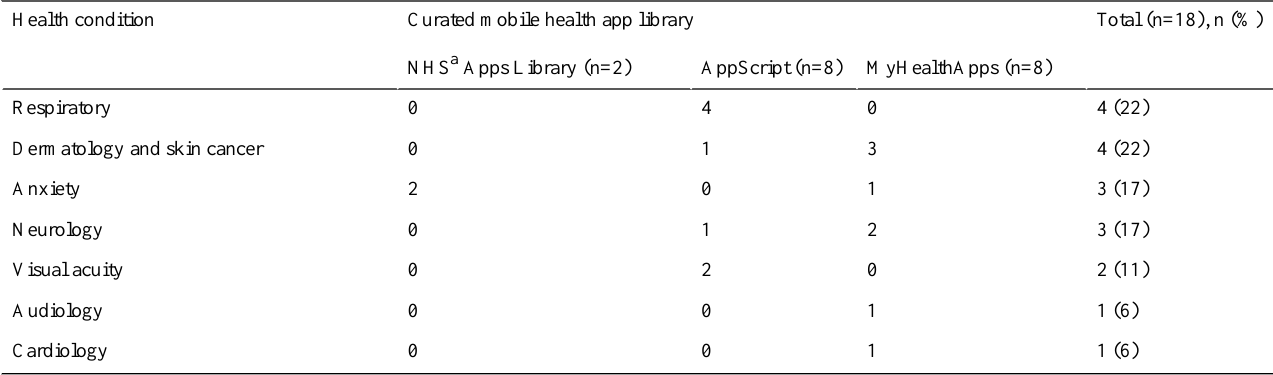
Table 5. Summary of health conditions where built-in mobile phone sensors were